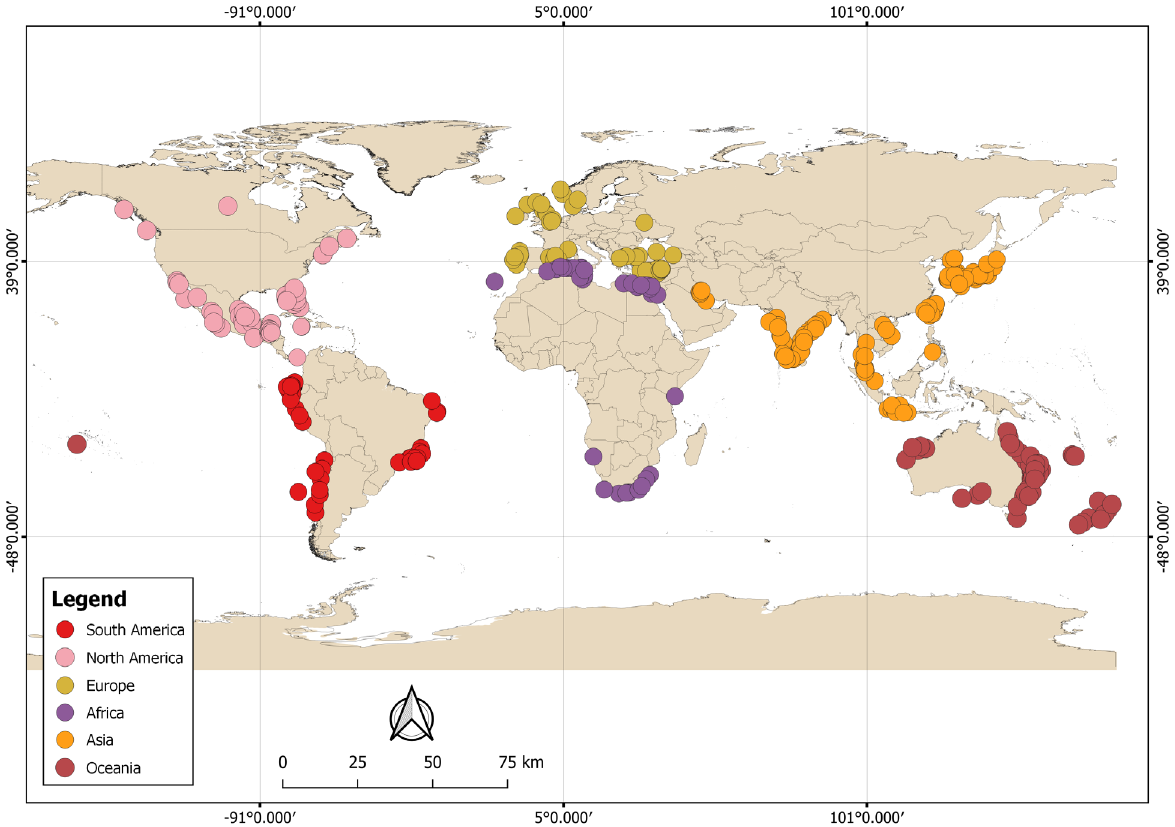
Figure 5. Geographical distribution of Caligus species on the continents of terrestrial